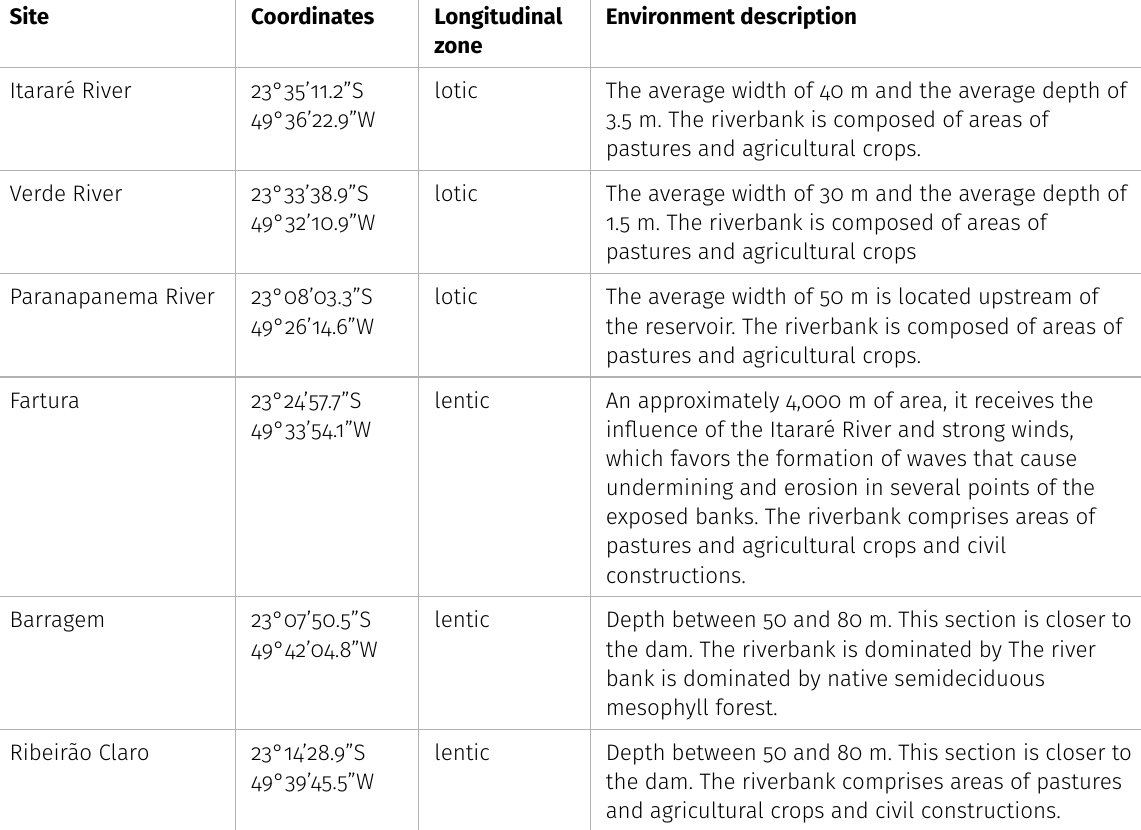
Table I. Description of sampled sites present in the Chavantes Reservoir, middle Paranapanema River basin.